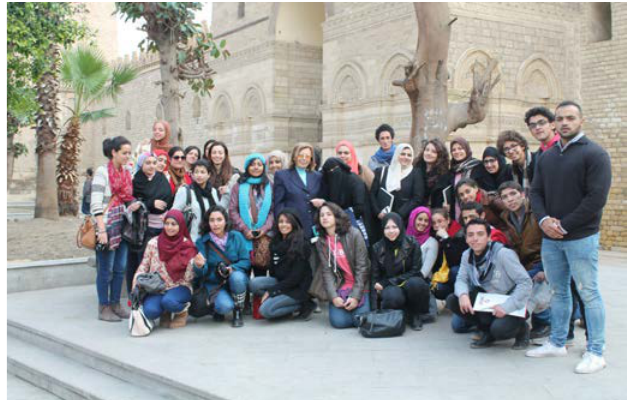
Figure (9): Live Model of Bait el Suhimey Field Trip supervised by Prof. Aleya Abdel Hadi (Head of Interior design department- Faculty of Arts and Design- MSA University) Source: Photos Library of MSA University.